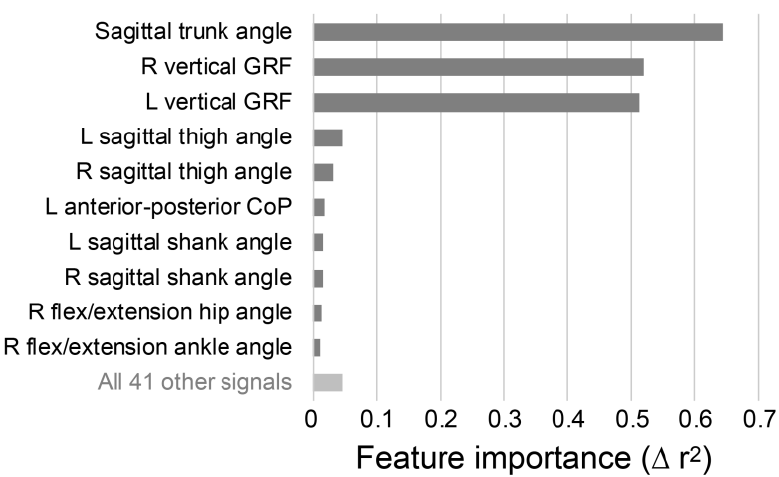
Figure 3. Sagittal trunk angle and vertical GRFs are the most important signals for estimating lumbar moments. Signal importances are from the idealized wearable sensor algorithm for estimating lumbar extension moments. R = right; L = left.